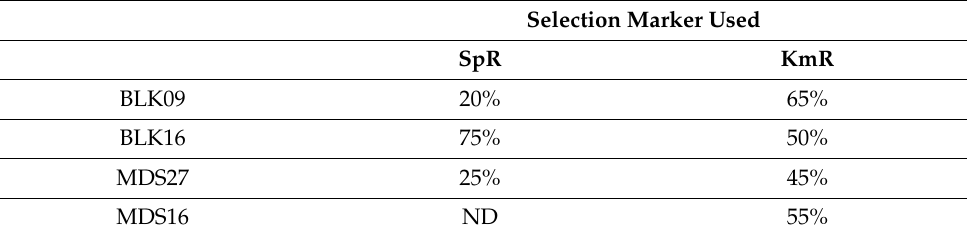
Table 3. The fraction of colonies obtained on the selective plate that carried the co-integrant at either IS 3 locus, as verified by PCR. Selection Marker Used SpR